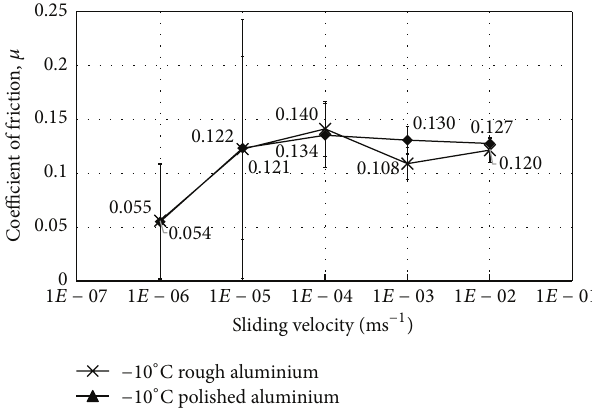
Figure 10: Friction as a function of sliding speed for ice on alu- minium, showing results for rough aluminium at − 10 ∘ C and − 2 ∘ C. The data compared herearealso shown separately in Figures 8 and 9.